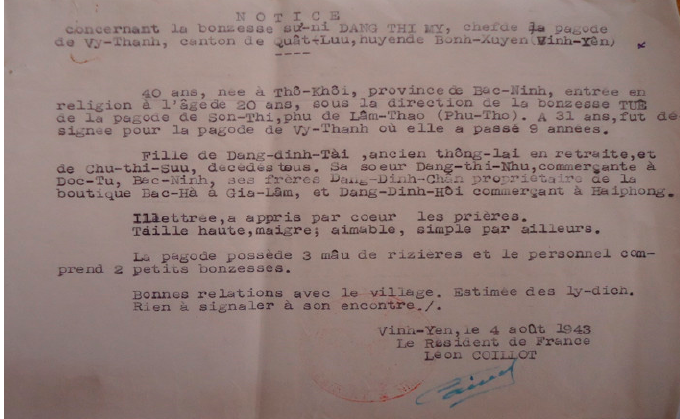
Figure 2. Nun Dang Thi My was a disciple of nun Tue (dossier